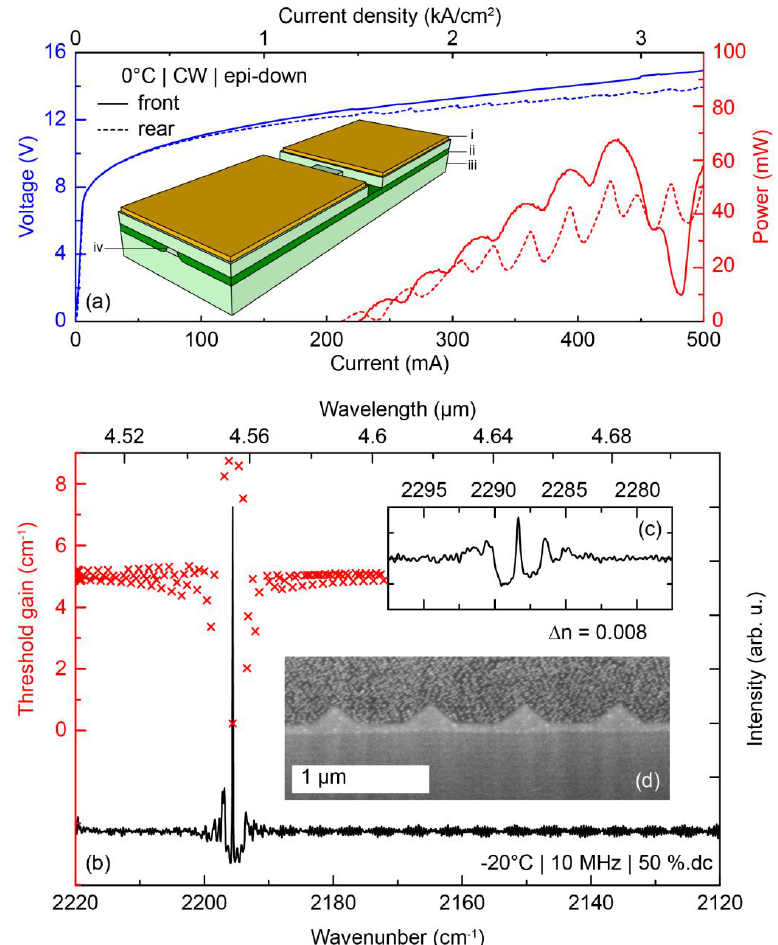
Figure 1. Device characteristics of the investigated dual-section DFB QCL. ( a ) LIV characteristic of a typical device with a device schematic in the inset. The color code for the inset is as follows: (i) yellow—Au electrode; (ii) dark green—insulating InP; (iii) light green—conducting InP; (iv) gray—dual-wavelength active region); ( b ) Sub-threshold electroluminescence revealing the stopband of the rear (b) and front ( c ) section. The spectrum is superimposed with a simulation of the threshold gain of each mode, highlighting that lasing occurs on the QWS; ( d ) FIB-SEM cross section through a laser revealing the wet-etched grating on top of the active region. The roughness seen in the upper part of this micrograph is ion-beam damage from the FIB